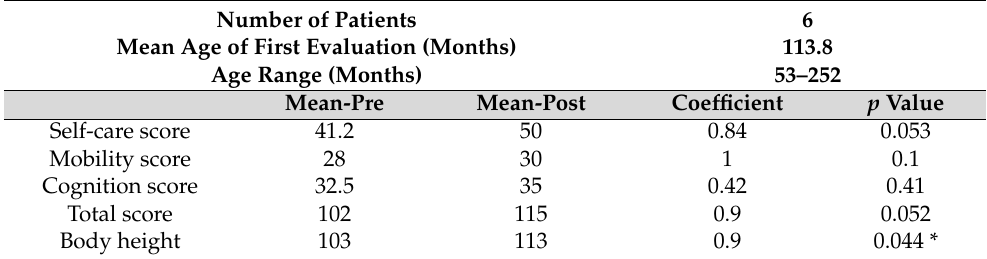
Figure 3. Regression analysis between WeeFIM scores and body height. Blue dots: subscores and body height of each patient; red dotted lines: regression curves for each subscores and body heights. Table 4. Comparison of WeeFIM scores and body height between two time